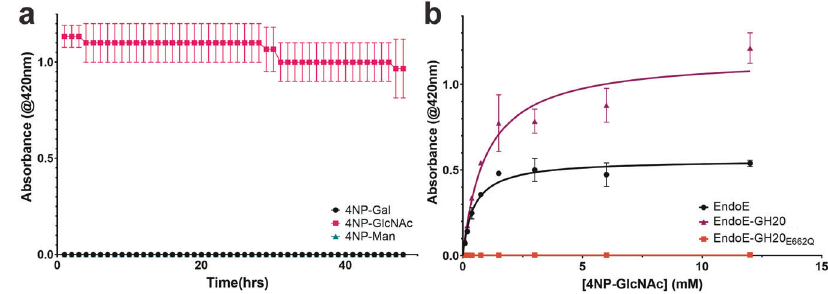
Fig. 7 Kinetic analysis of EndoE-GH20 domain substrate speci fi city. a Determination of EndoE-GH20 domain substrate speci fi city by 4-nitrophenol (4NP) linked substrates. b Kinetic analyses of GH20 domain as part of EndoE or alone. The data plotted is the mean of three independent experiments (n), with the standard deviation (SD) being plotted as the error. Source data are provided as a Source Data fi